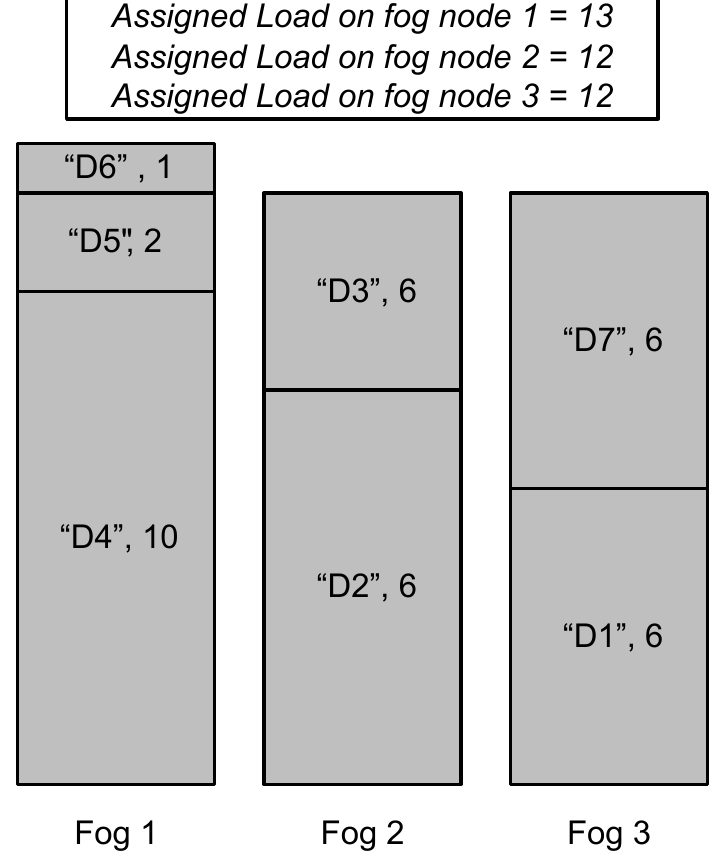
Figure 3. Example of the proposed algorithm technique. A complete algorithm for load distribution is shown in Algorithm